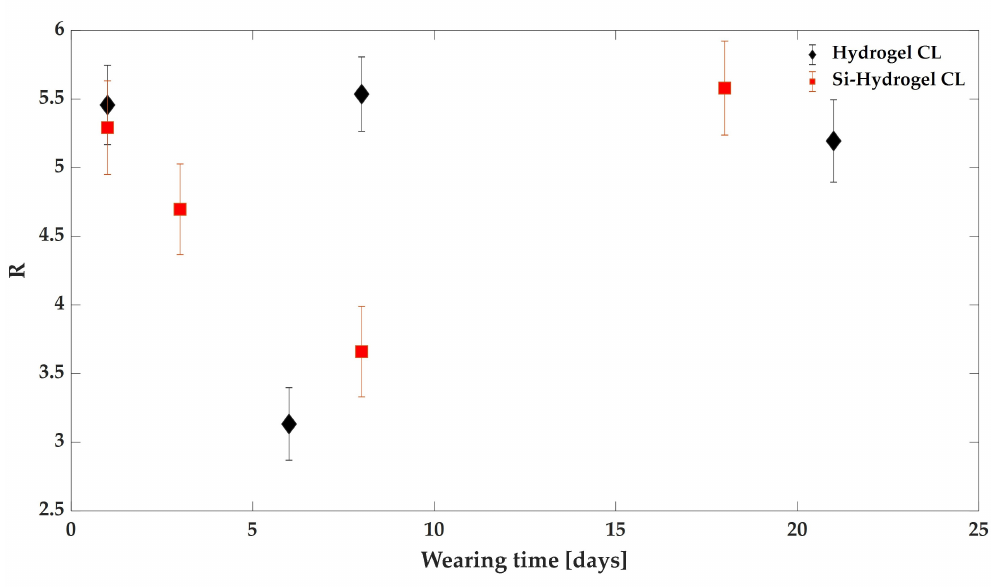
Figure 8. Raman intensities ratio I 2930 / I 2845 reported as function of the wearing time for both the